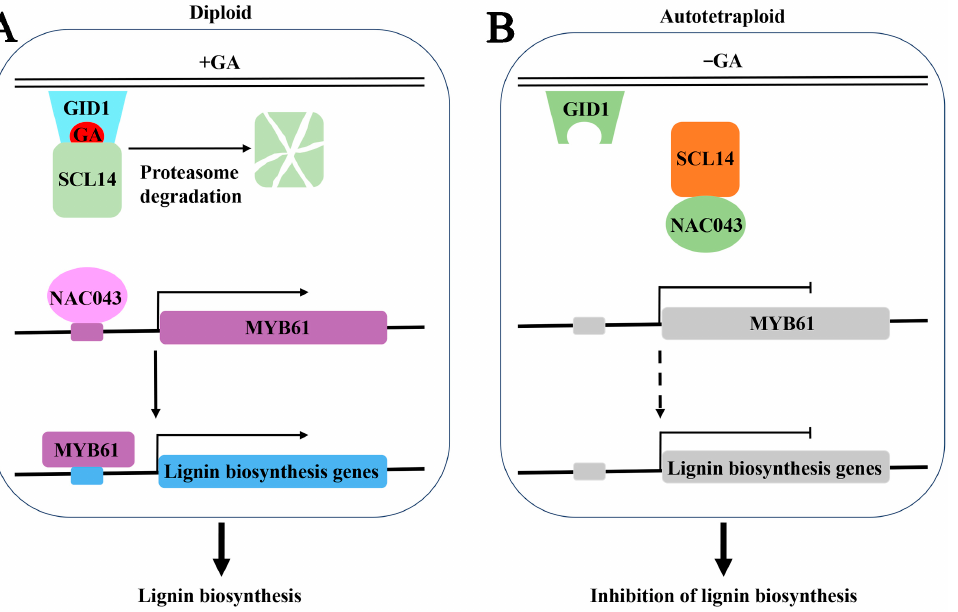
Figure 10. Putative model of the regulatory mechanism of lignin biosynthesis in diploid and autotetraploid P. hopeiensis. ( A ) In diploids, high concentrations of GA trigger the proteasomal degradation of SCL14 and frees the NAC043 to activate the expression of downstream MYB61 and lignin monomer synthase gene, which consequently promotes lignin biosynthesis. ( B ) In autotetraploids, low concen- trations of GA promote the activity of SCL14. SCL14 interacts directly with NAC043, suppressing the NAC043–MYB61 signaling cascade and inhibiting lignin